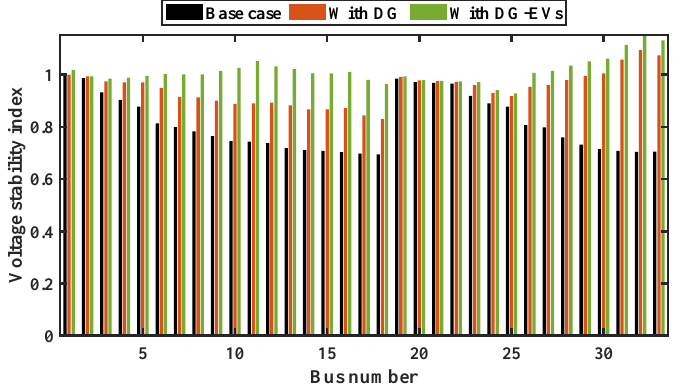
Figure 7. Voltage stability factors at 33 buses of modified test system.